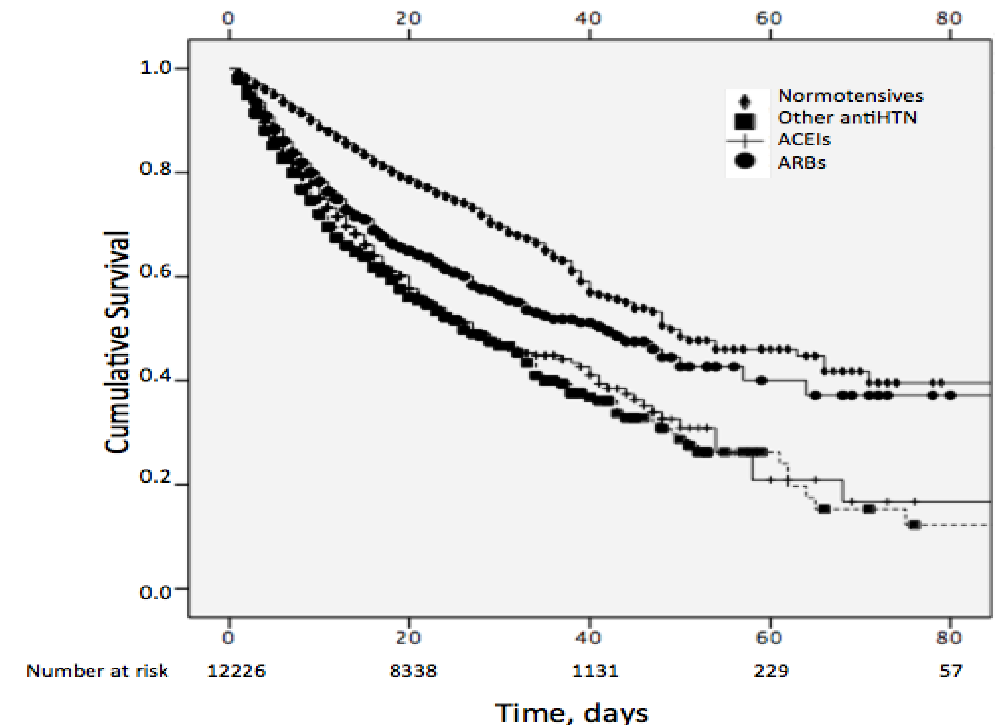
Figure 3. Kaplan–Meier curves in patients with/without hypertension according to previous antihypertensive treatment. Log rank p < 0.001. Table 2. Demographic and baseline clinical features of the study population. according to hypertension (HT) status and treatment. COPD: chronic obstructive pulmonary disease; CKD: chronic kidney